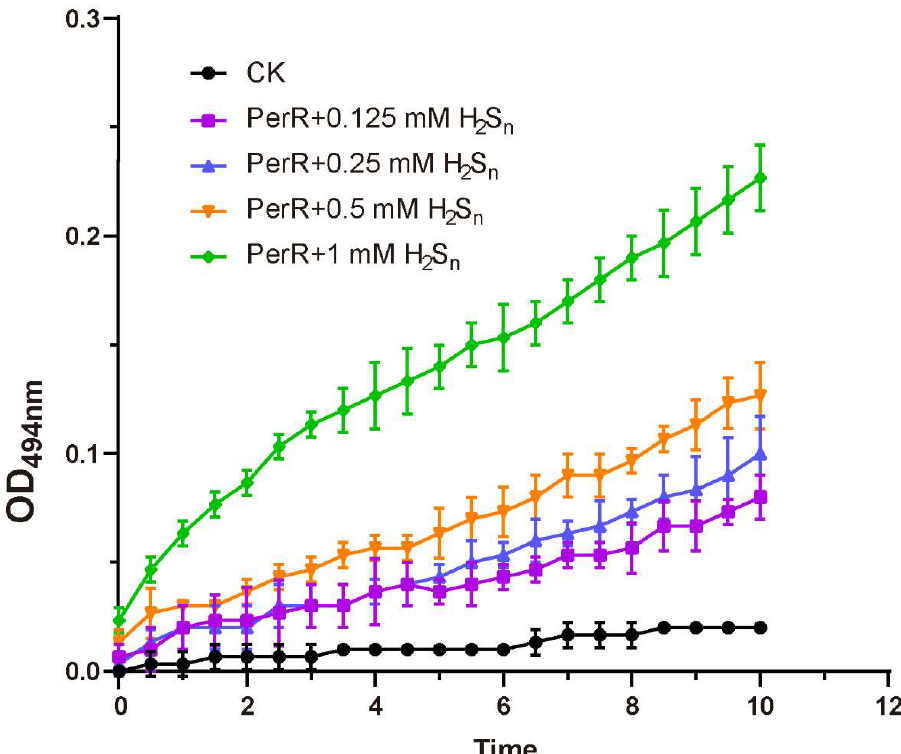
Figure 4. H 2 S n caused dissociation of zinc ions from PerR. Oxidation of the Cys 4 :Zn 2+ site by H 2 S n led to Zn 2+ release. H 2 S n was incubated with 100 μM PerR, and formation of the Zn 2+ -PAR complex was continuously monitored by measuring the absorbance at 494 nm for 10 min. All data are averages from three samples with standard deviations (error bars). The experiment was repeated at least three times.